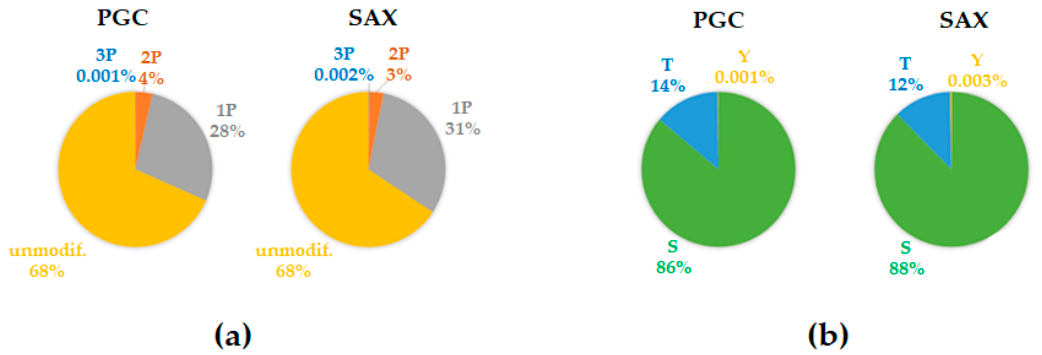
Figure 2. Phosphopeptide enrichment using the Fe-IMAC strategy. ( a ) The graph shows the average composition of the mono- (1P), double- (2P), and multi- (3P) phosphorylated peptides or unmodified peptides in separate PGC and SAX fractionation experiments. ( b ) The panel illustrates the percentage of individual phosphorylated amino acid residues (S-serine, T-threonine, and Y-tyrosine) in the modified peptides identified in the PGC and SAX fractionated samples.